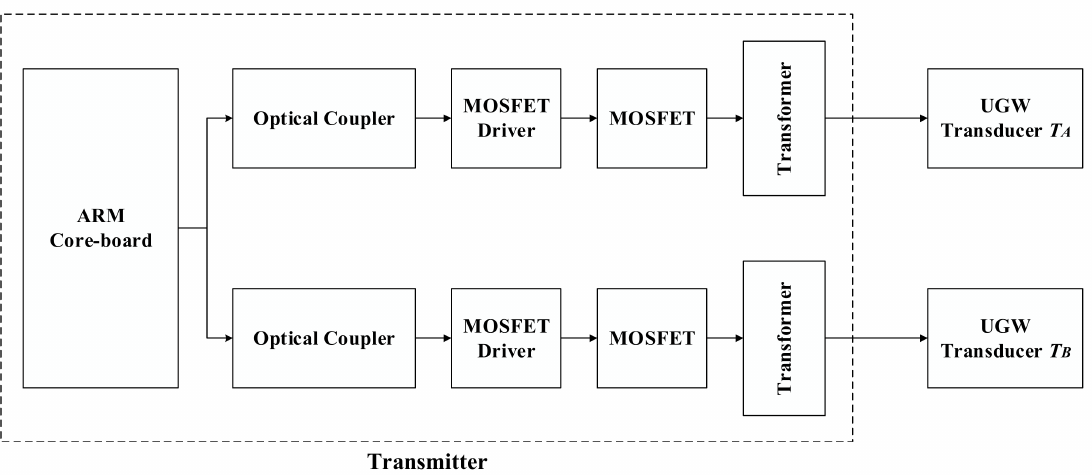
Figure 2. Block diagram for the UGW transmitter.